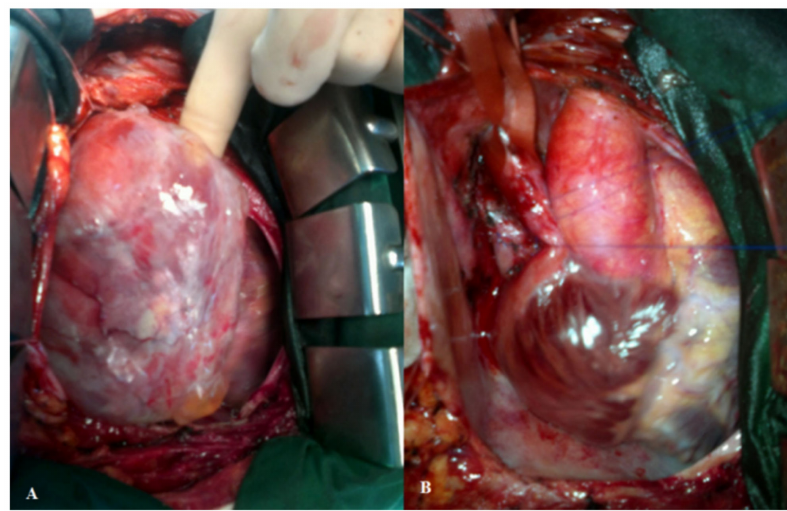
Figure 2. Intraoperative findings: a large, encapsulated mass developed along the entire right aspect of the heart. ( A ): Preoperative image; ( B ): Postoperative image: the SVC can be identified by the blue thread around it.